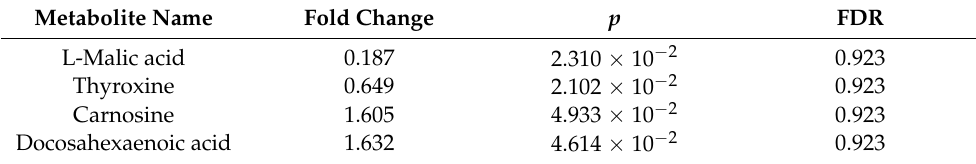
Table 3. List of the altered metabolites identified in the comparison between SN1 and